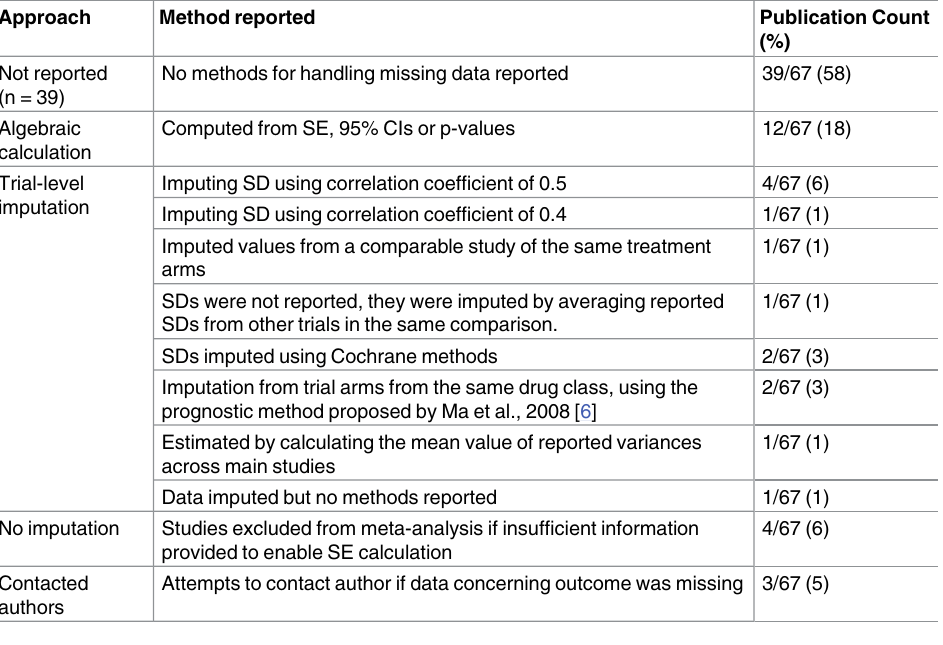
Table 2. Summary of approaches to dealing with missing variance data across the included